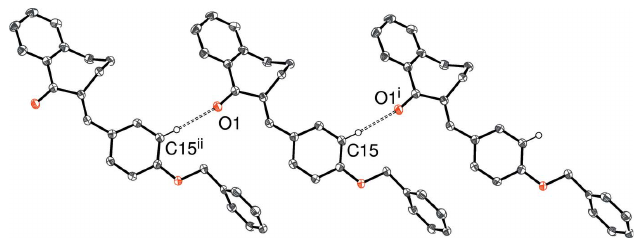
Figure 9 Fragment of the crystal structure of (III), showing part of a [100] chain